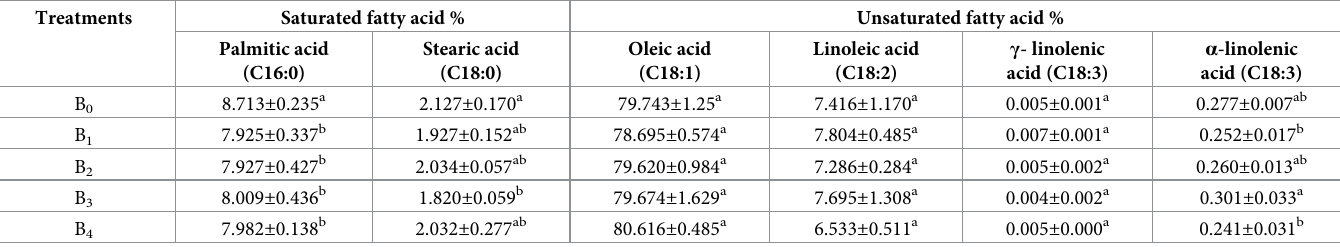
Table 3. Saturated and unsaturated fatty acids in the fruit of C . oleifera fertilized by different amounts of biogas slurry. Treatments Saturated fatty acid % Palmitic acid